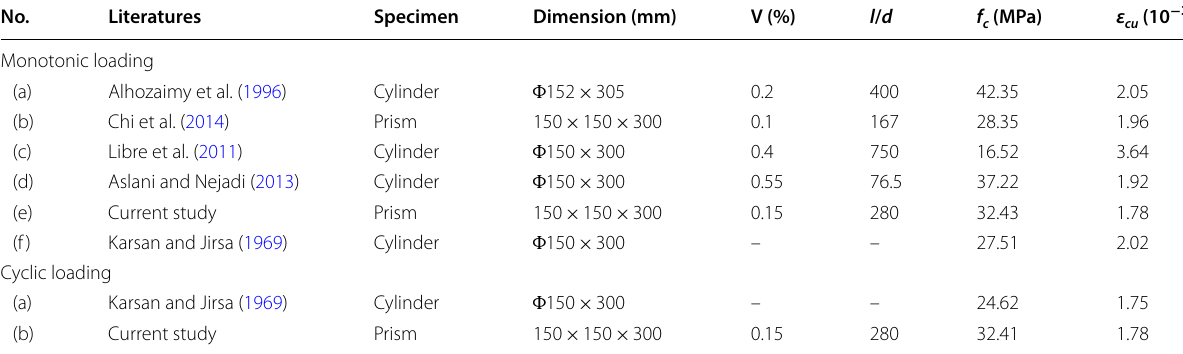
Table 5 Key mechanical parameters used in the model verification.